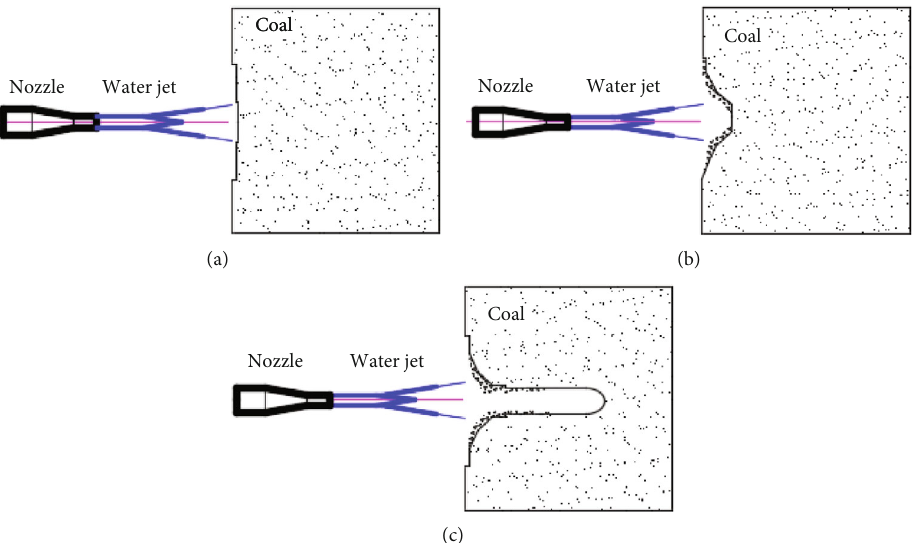
Figure 14: Di ff erent stages of HPWJ-induced coal crushing.